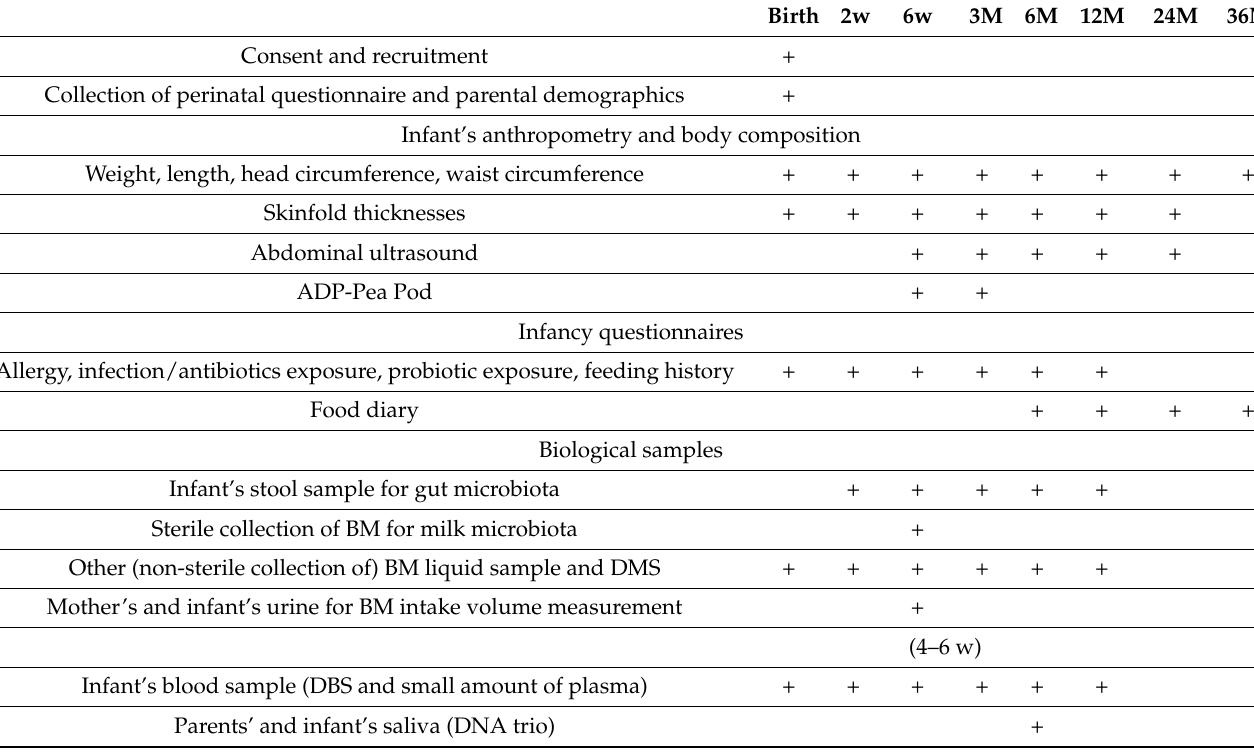
Table 1. Data, anthropometry, and biological samples collection during each visit in the Cambridge Baby Growth and Breastfeeding Study (CBGS-BF).